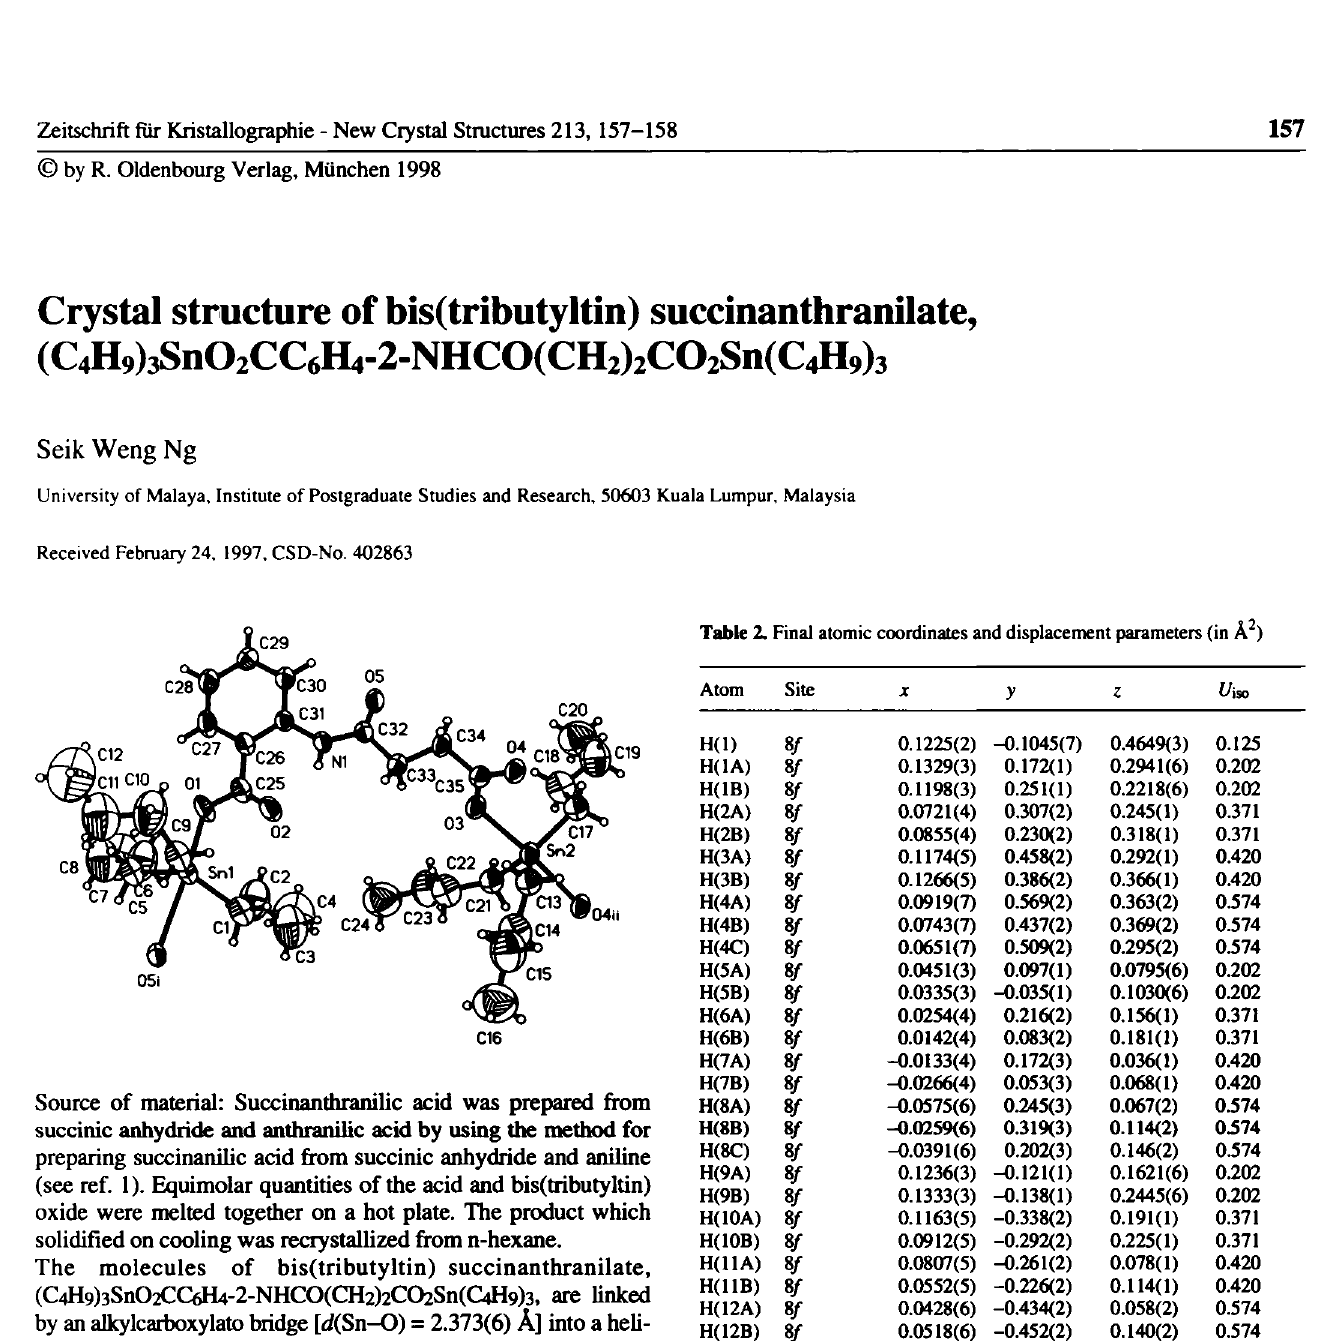
Table 1. Parameters used for the X-ray data collection